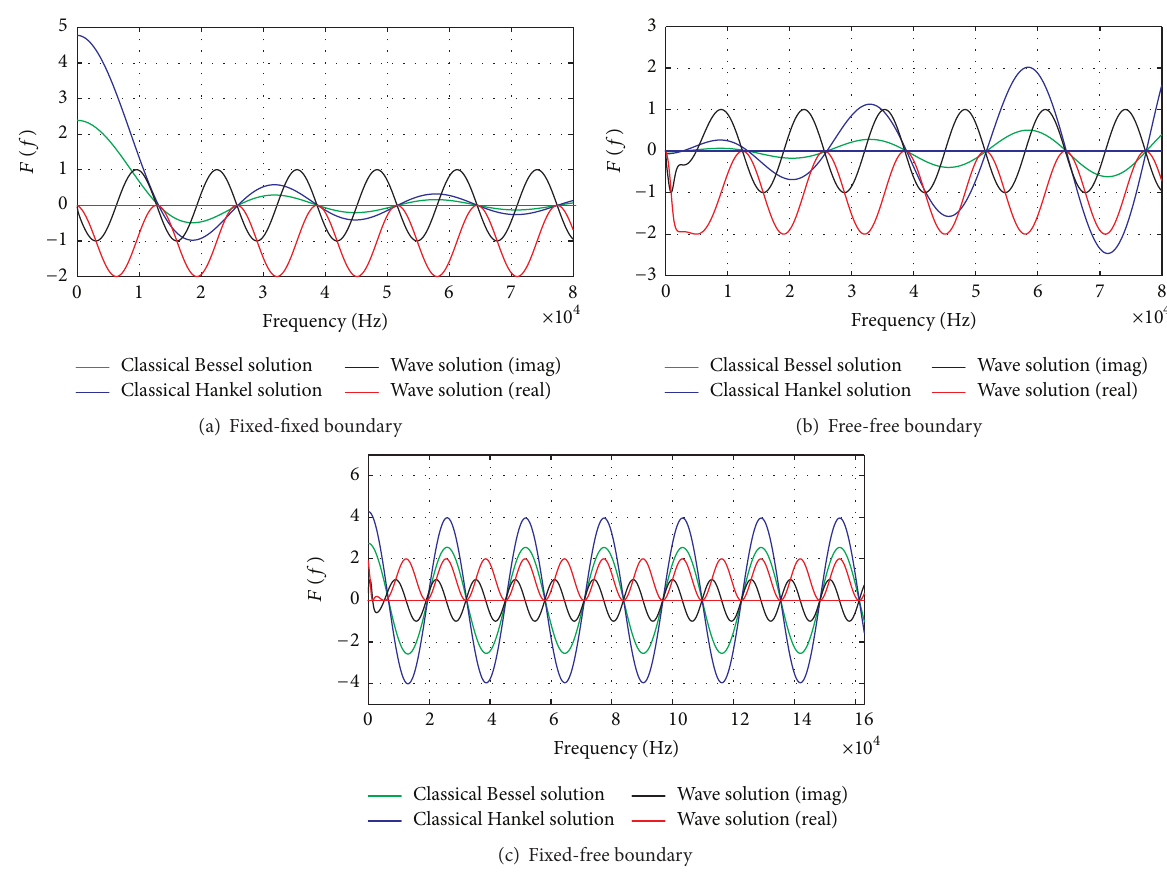
Figure 2: Natural frequency calculated by classic method and wave approach.